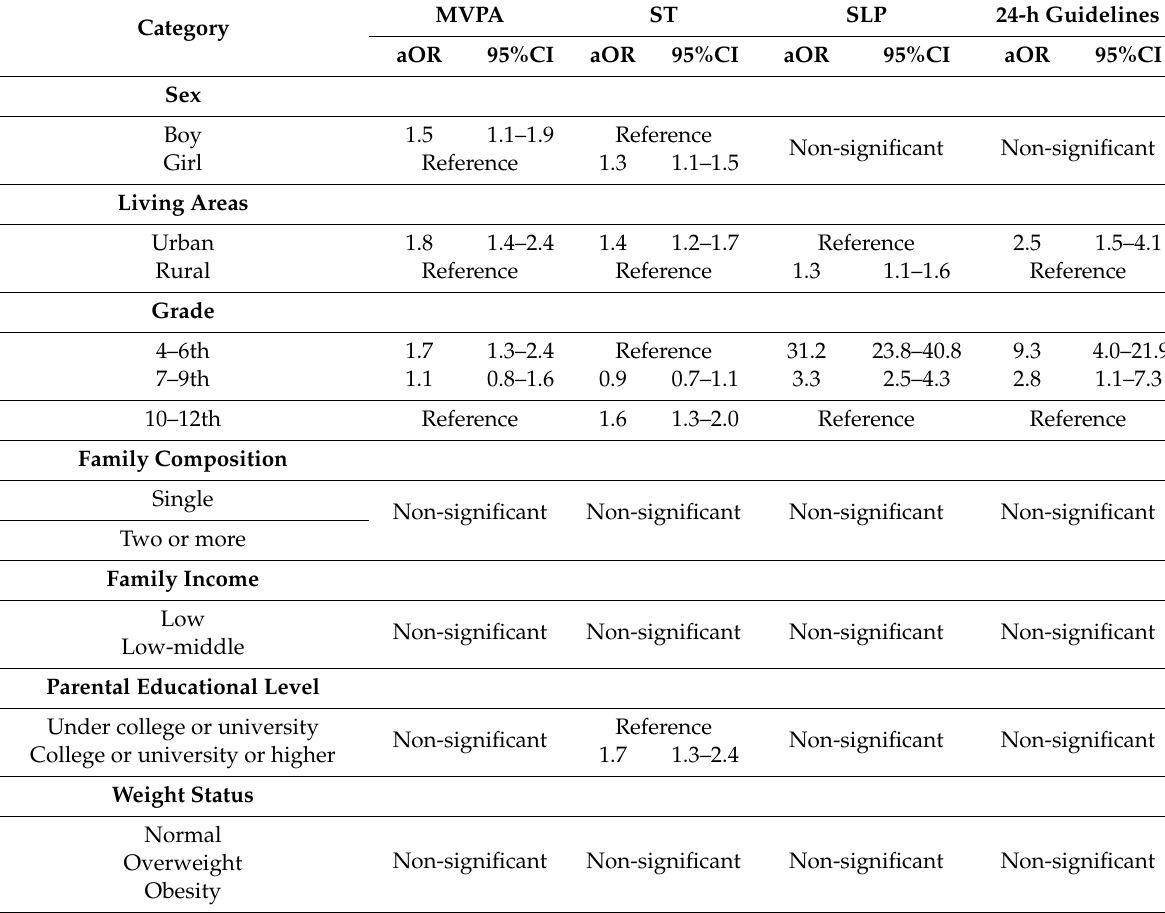
Table 3. Correlates of the prevalence of meeting the MVPA, ST, SLP, and 24-h